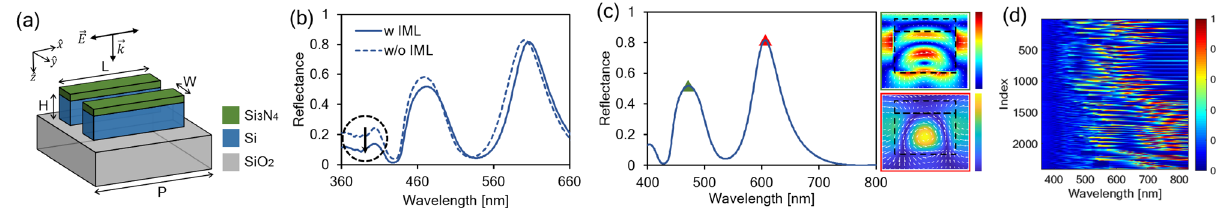
Figure 2. ( a ) A schematic illustration of the dual-resonance metasurface composed of parallel silicon rods covered by silicon nitride index matching capping layer onto them. ( b ) Background reflectance suppression effect obtained when 40 nm-thick index matching layer is applied. ( c ) Reflectance spectrum and electromagnetic field distributions of the corresponding resonance peaks ( P = 290 nm, H = 160 nm, L = 210 nm, W = 50 nm). Electromagnetic field distributions are seen from the center of bar in zx -plane. At the peak of shorter wavelength (green square), arrows and color maps indicate the direction and amplitude of the electric field, respectively. In the case of longer wavelength (red square), color maps indicate the amplitude of magnetic field, but arrows correspond to the direction of electric field. ( d ) Reflectance map in the visible region calculated in design space when adjustable geometric parameters are set to P, H, L, and W